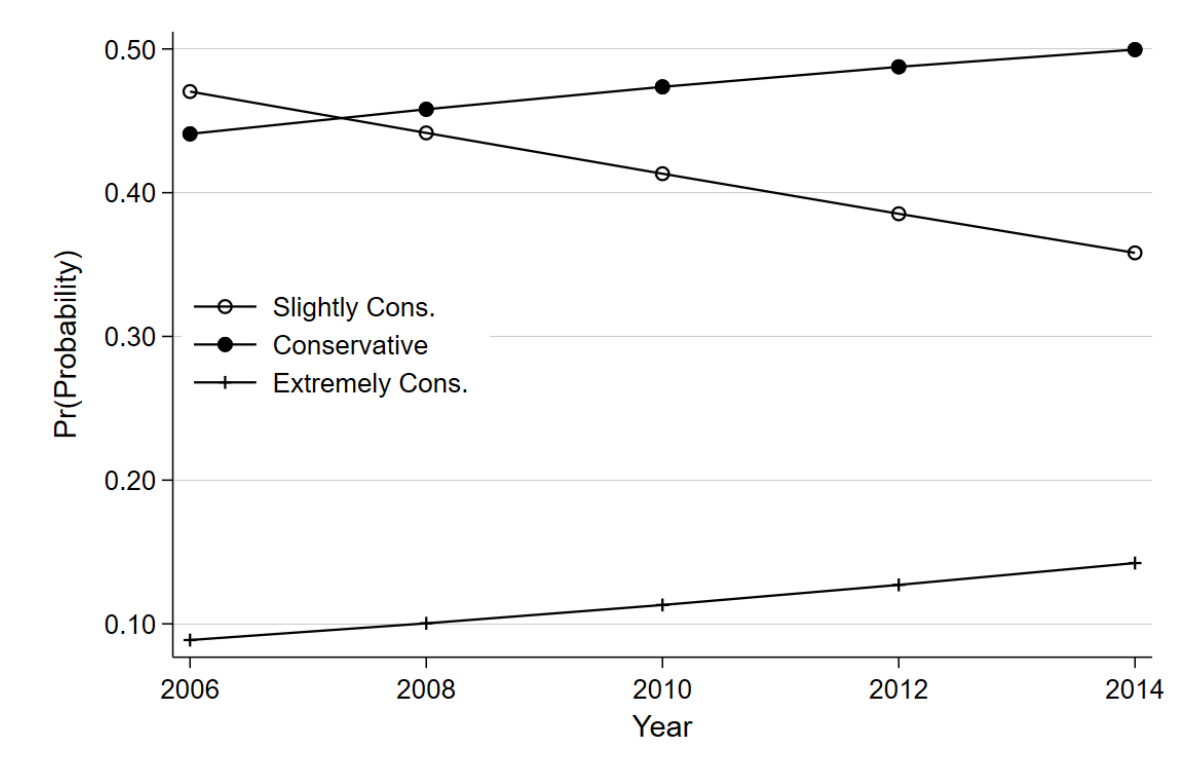
Figure 6: Predicted probabilities of conservative identity strength: GSS panel data, 2006 to